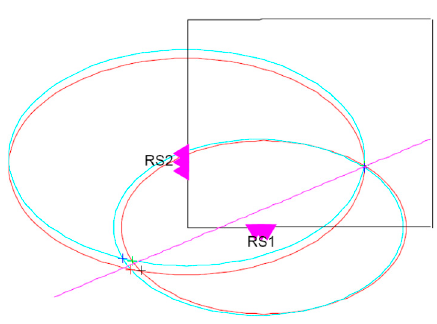
Figure 9. Lines No. 3, 4, 5, and 6 guided by the intersections of ellipse sets RS1 and RS2 in the point τ = 100.